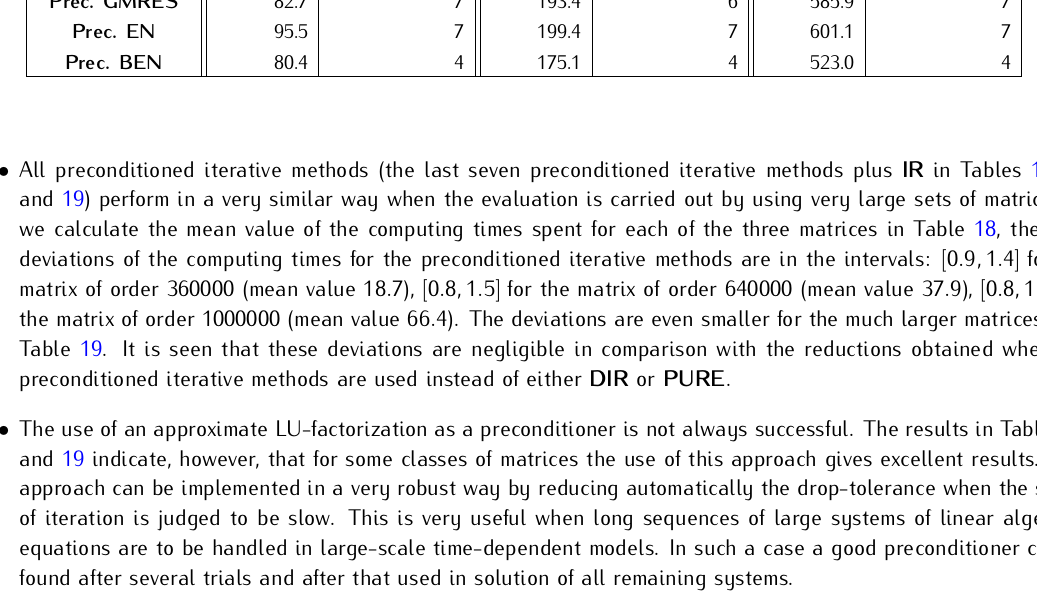
= C 2 , δ = 2 and γ = 1 are used. The